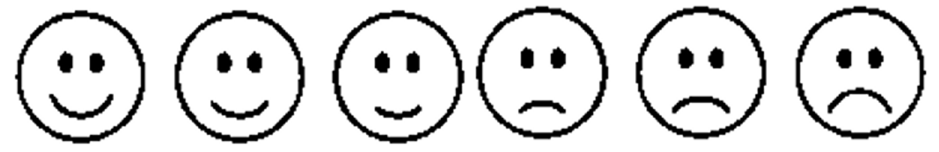
Figure 3. 6-point smiley analogue scale, ranging from the happiest (‘very, very happy’) to the saddest smiley (‘not at all happy’).